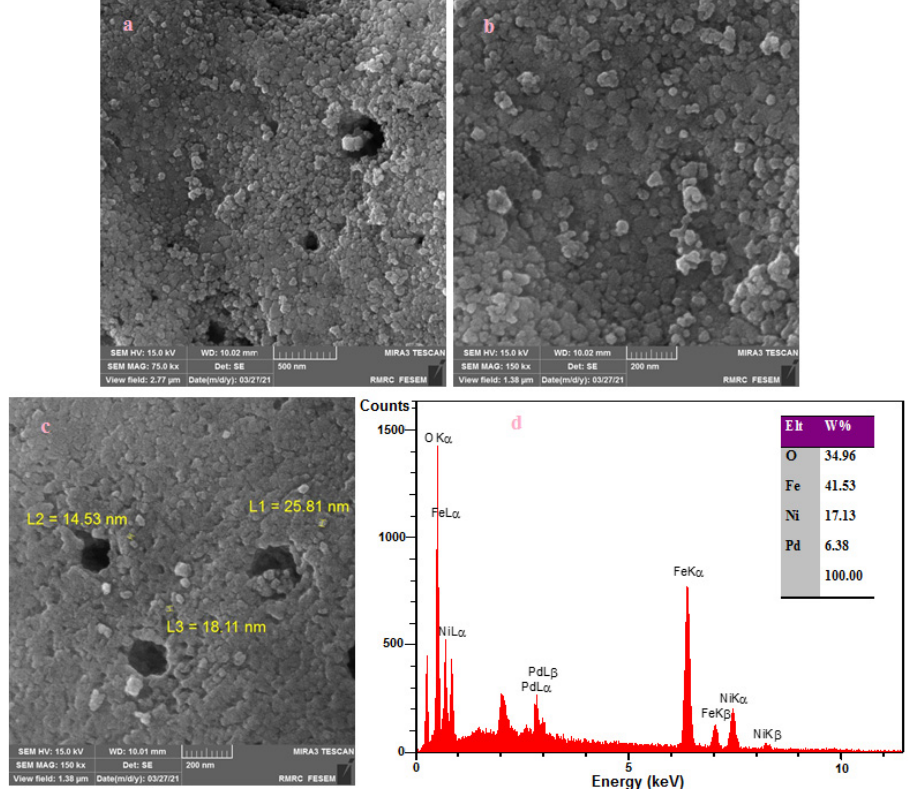
Fig. 3. The (a-c) FESEM images and (d) EDX spectrum of Pd/NiFe 2 O 4 nanocomposite.